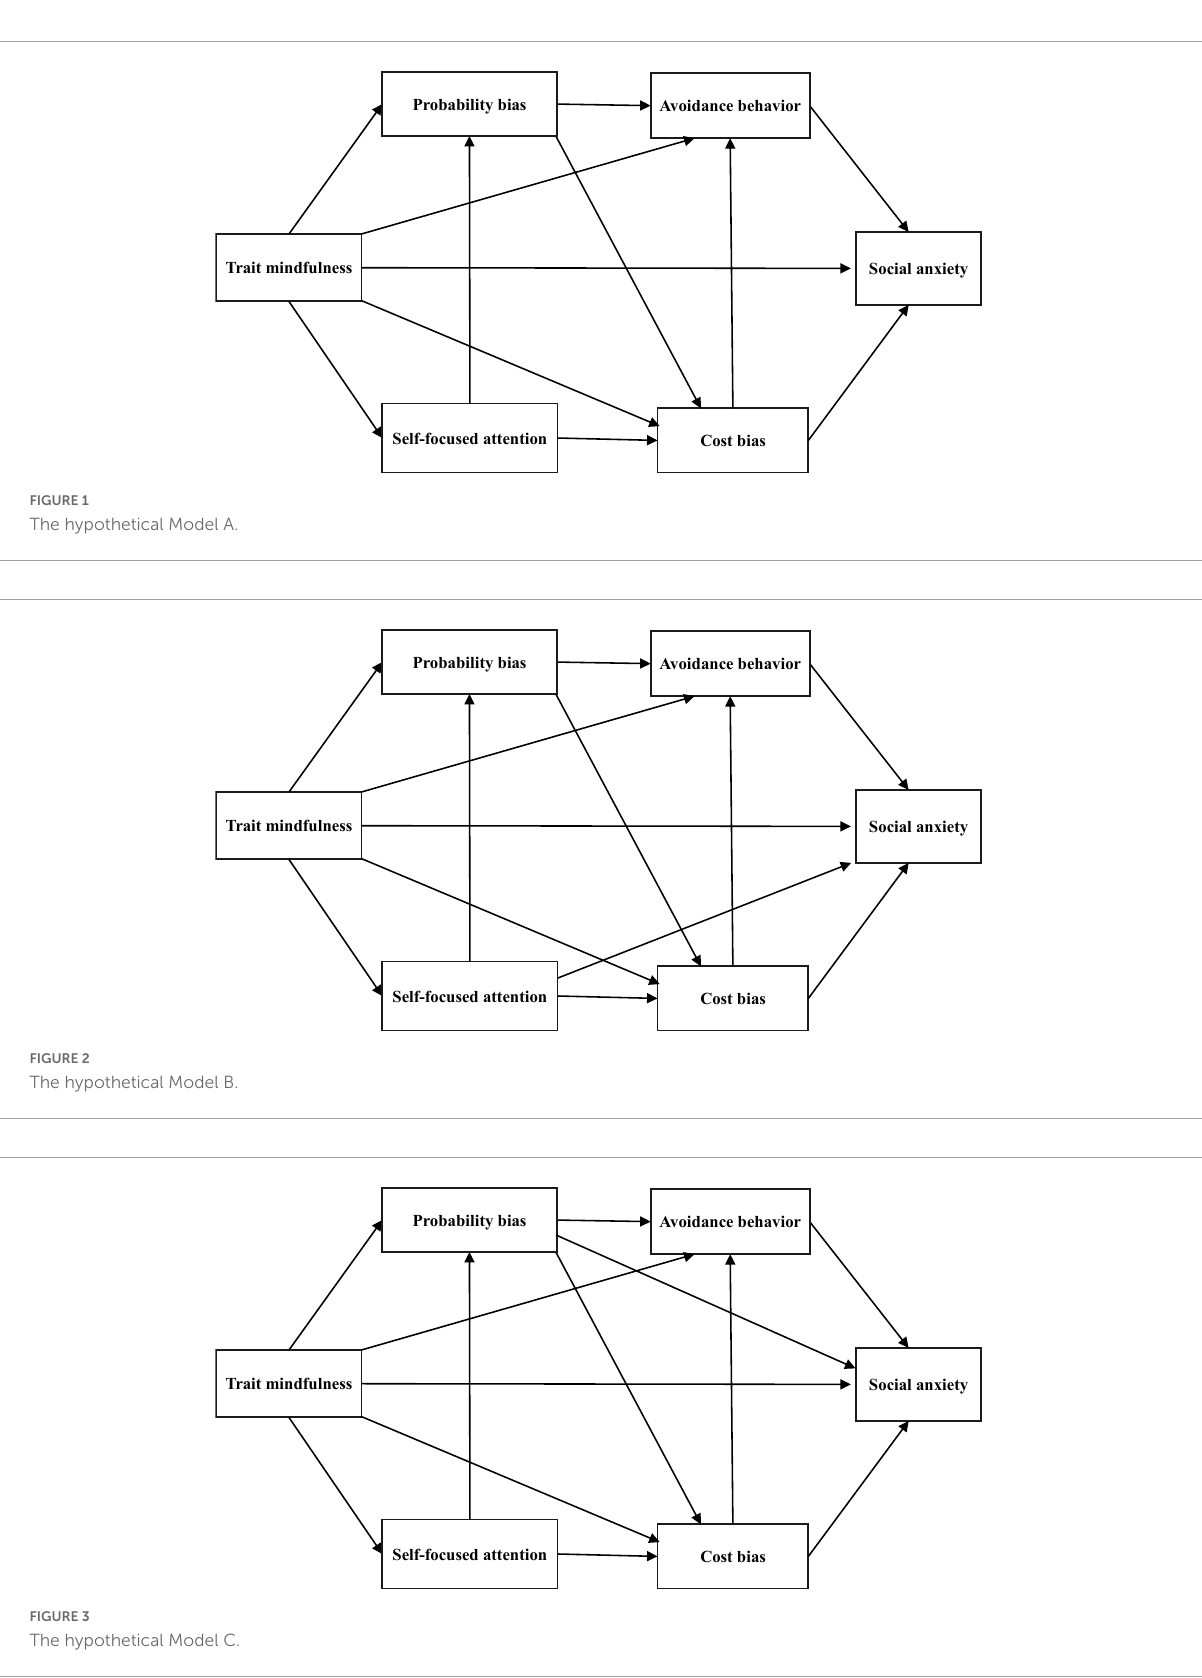
FIGURE3 The hypothetical Model